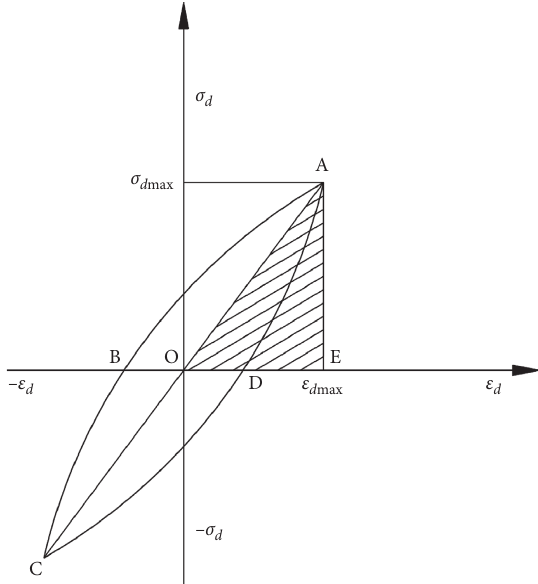
Figure 4: Dynamic stress-strain hysteresis loop.